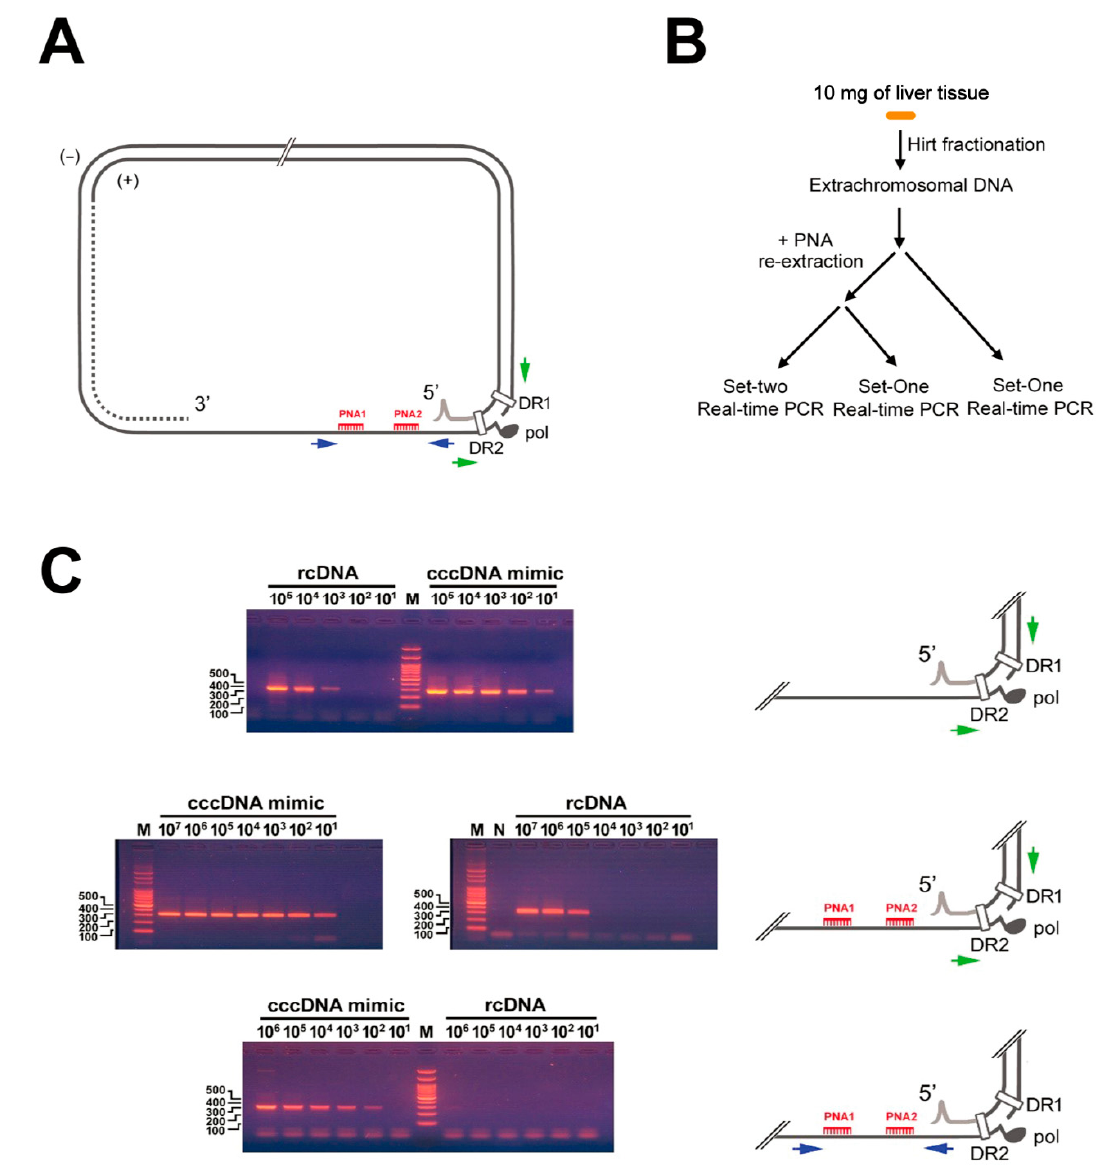
Figure 1. Schematic representation of peptide nucleic acid (PNA)-clamping based covalently closed circular DNA (cccDNA) assays. ( A ) Positions of all primers used. Red combs, two PNA primers, PNA1 and PNA2, used to “clamp” the single stranded region of minus-stranded hepatitis B virus (HBV)-DNA; green arrows, traditional cccDNA specific qPCR primers (Set-one primers); dark blue arrows, primers flanking the PNA-clamping primers (Set-two primers). Gray fragment, RNA fragment on the 5 (cid:48) -end of plus-stranded HBV-DNA; black solid oval, polymerase (pol) linked to the 5 (cid:48) -end of minus-stranded HBV-DNA. The areas of DR1 and DR2 were also marked. ( B ) Procedures for cccDNA quantification (see Methods). ( C ). Specific detection of cccDNA by the PNA clamping qPCR method. It was found that with no pre-PNA clamping, cccDNA specific primers (green), can only specifically detect cccDNA from 1 to 10 2 copies (upper). When preclamping is performed, cccDNA can be specifically detected up to 10 4 copies using cccDNA specific primers and 10 2 to 10 5 copies using Set-two primers (dark blue).